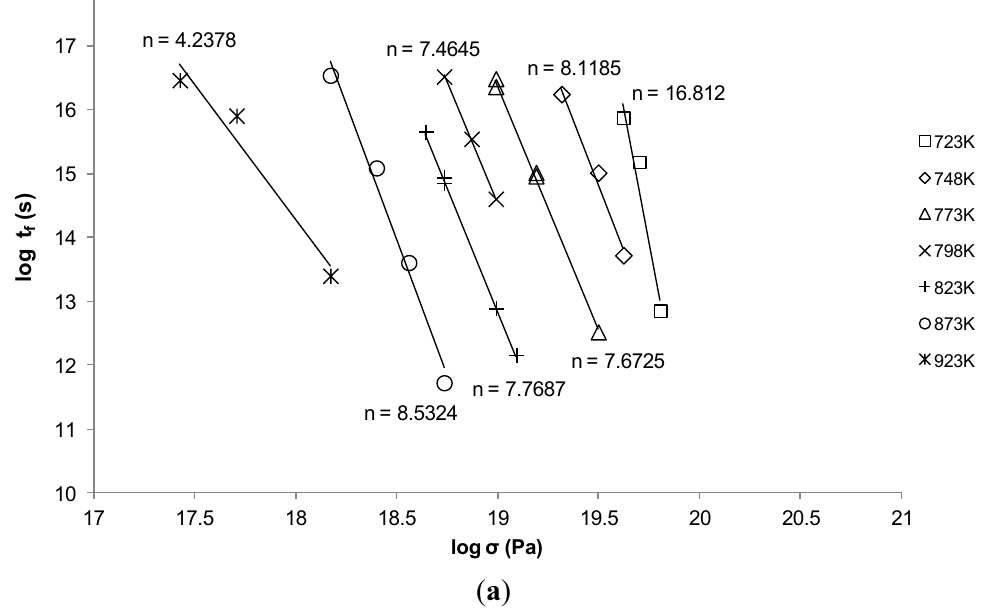
Figure 1. The calculation of the: ( a ) stress exponent n ; ( b ) the activation energy Q various conditions for Grade 22